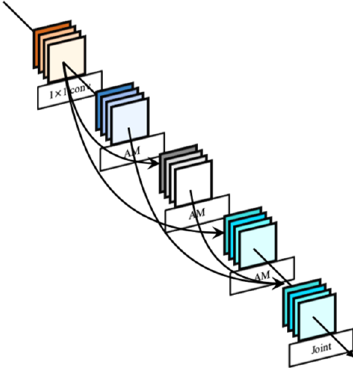
Figure 3. Overall structure diagram.